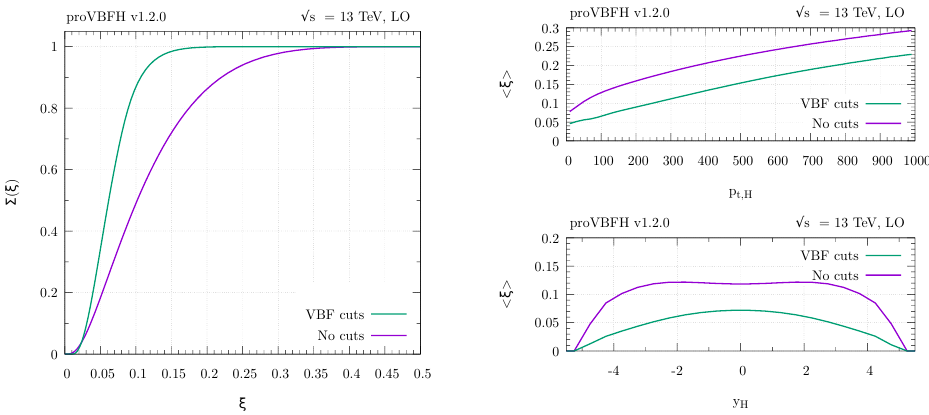
Figure 9. (left) The normalised integrated cross section as a function of (cid:24) fully inclusively (purple) and under the VBF cuts of section 3.1 (green) for single Higgs production through VBF. (right) The average of (cid:24) as a function of y H and p t;H